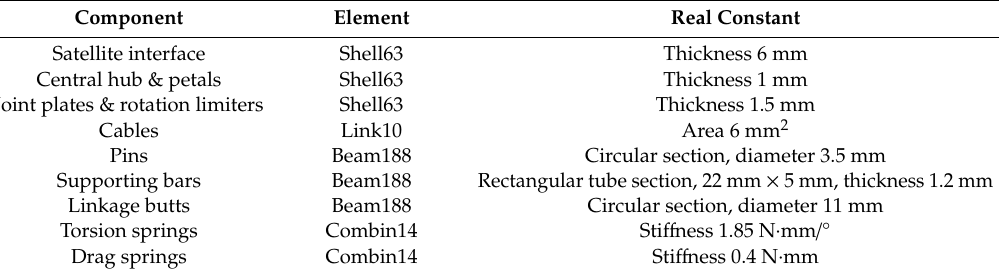
Figure 3. ANSYS model without drag springs. Table 2. Elements and real constants.